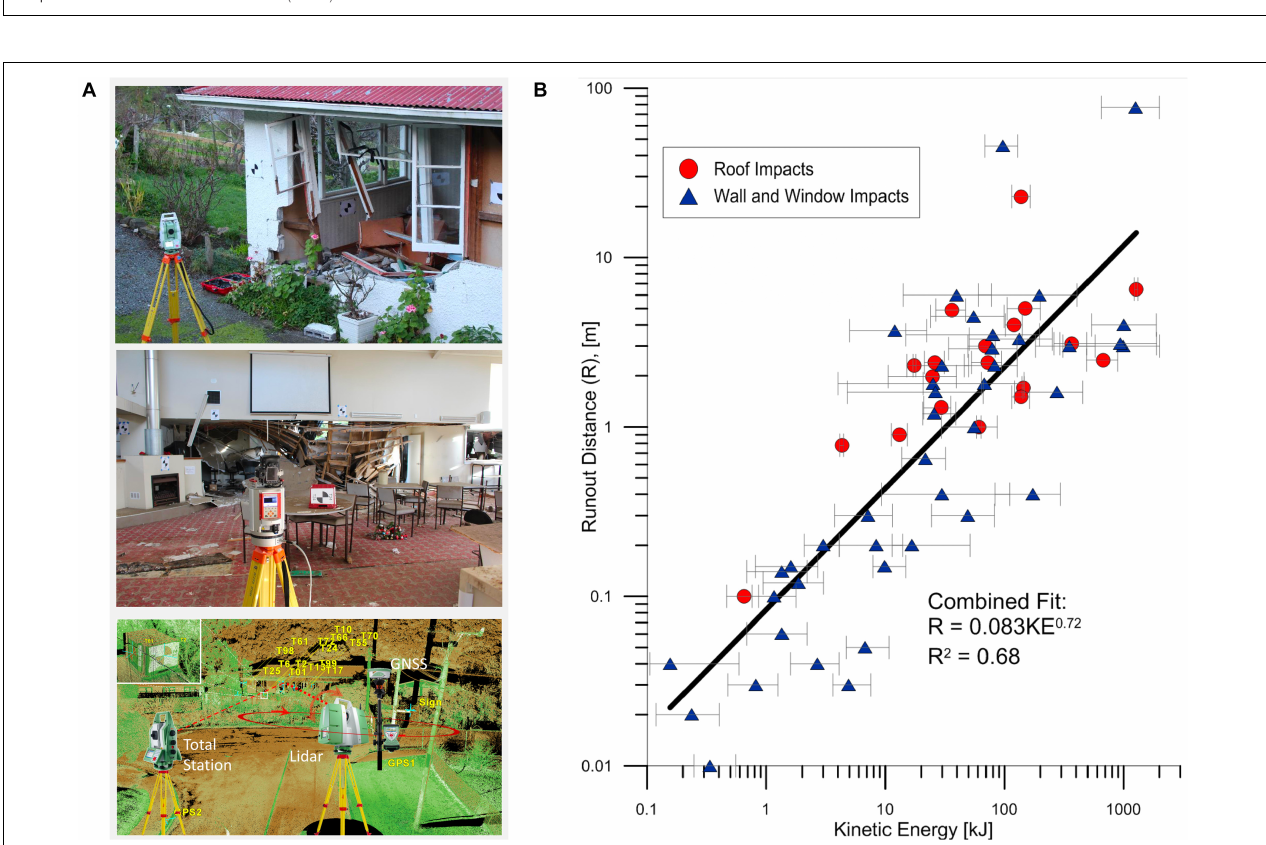
FIGURE 3 | Reconnaissance investigation of the impact of rockfalls on dwellings during the 2011 Christchurch, New Zealand, earthquakes. (A) Lidar data was collected inside and outside buildings, geo-registered, then fusing into a single 3D model. (B) Field data reveals a direct correlation between rockfall impact energy and rock penetration into buildings. Modified from Grant et al.